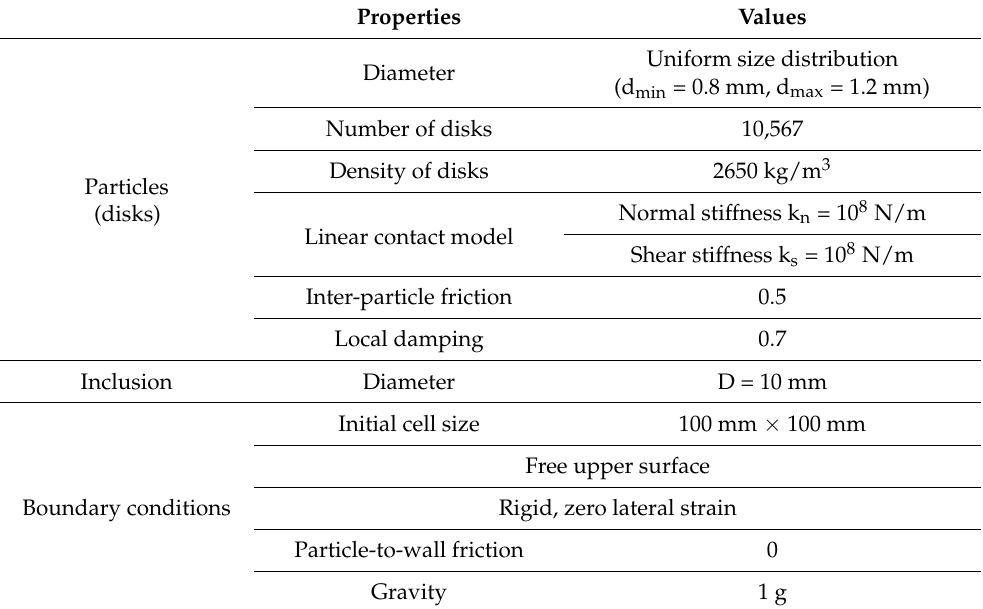
Table 1. Two-dimensional discrete element simulation